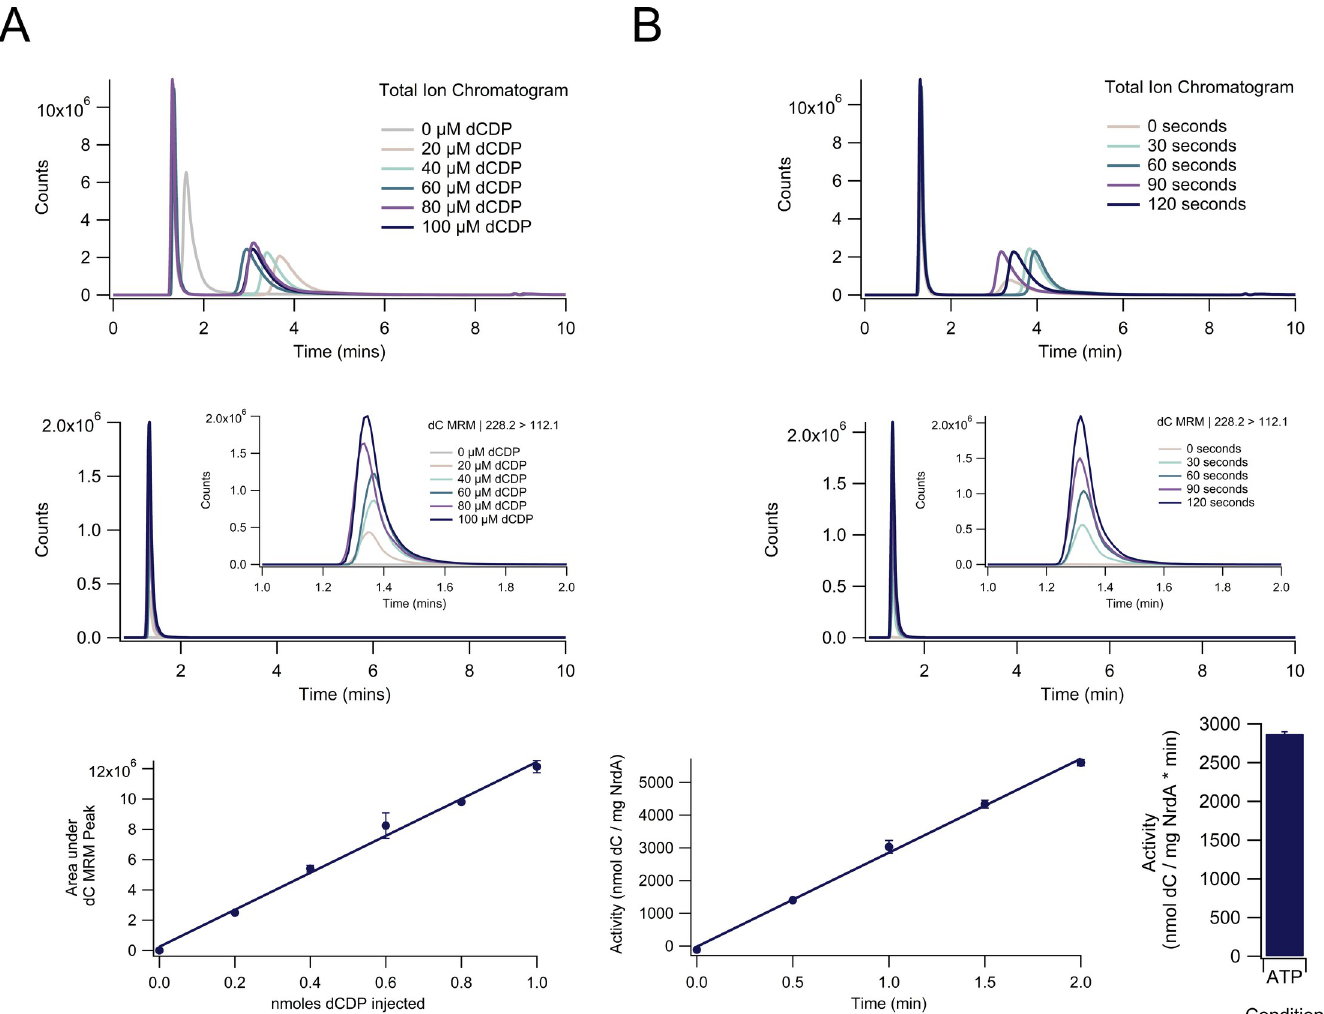
Fig 3. Measurement of RNR activity for a single nucleotide under a single condition. (A) Generation of a dC standard curve. A multiple reaction monitoring (MRM) curve for dC (m/z 228.2 > 112.1) is extracted from the initial total ion chromatogram (TIC) and the peaks are integrated (all in triplicate; one set of standards is shown above for the TIC and MRM) to generate a standard curve that relates the area under the dC MRM peak to the nmoles dC injected. The peak in the TIC at approximately 1.4 mins corresponds to the desired dephosphorylated product (dC) whereas the peak at approximately 3.5 mins corresponds to the dephosphorylated effector (A) in this experiment; note the MRM peak for dC is at the same retention time as the dC peak in the TIC. (B) Calculation of sample activity. Another set of MRM curves are extracted and integrated from TICs for each of the time points of the assay. The integrated MRM values are then converted to nmol dC / mg NrdA by using the standard curve to calculate nmol dC injected and then dividing by the mg NrdA in each injection. The slope of the line (in nmol/mg-min; after the aforementioned has been completed in triplicate) is the activity of the protein. All reactions are done in triplicate and are shown as mean ± standard error of the mean. The above condition contained NrdA (0.1 μ M dimer), NrdB (0.5 μ M dimer), ATP (3000 μ M), CDP (1000 μ M), Trx (30 μ M), TrxR (0.5 μ M), and NADPH (200 μ